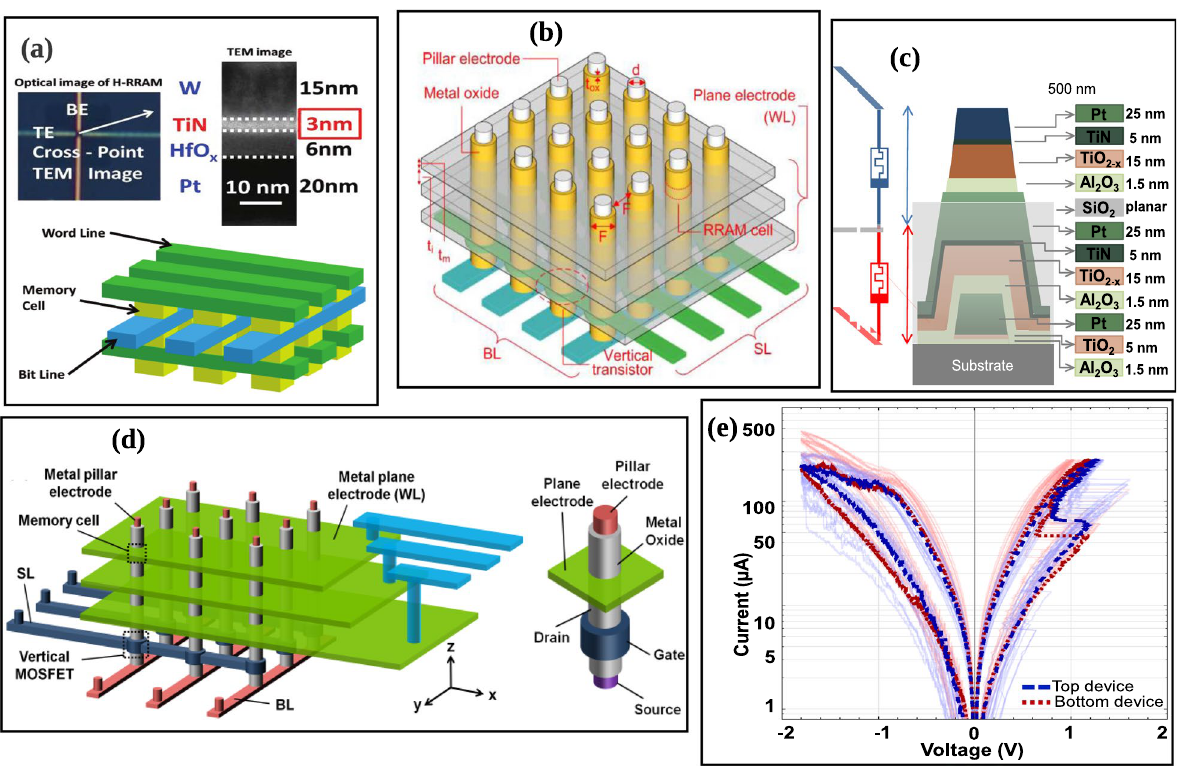
Fig. 15 Schematic of the 3D horizontally and vertically stacked crossbar array structures. a Structure of the 3D horizontal RRAM array [119]. b Structure of the 3D vertical RRAM array [121]. c Circuit of a stacked memristor consisting of a shared middle electrode, shown in grey between the blue and red memristor devices [126]. d Structure of a 3D cross-point design showing vertical RRAM cell with vertical MOSFET [122]. e The plots of I–V for the red device (red dotted) and blue device (blue dotted), also shown as top and bottom device,